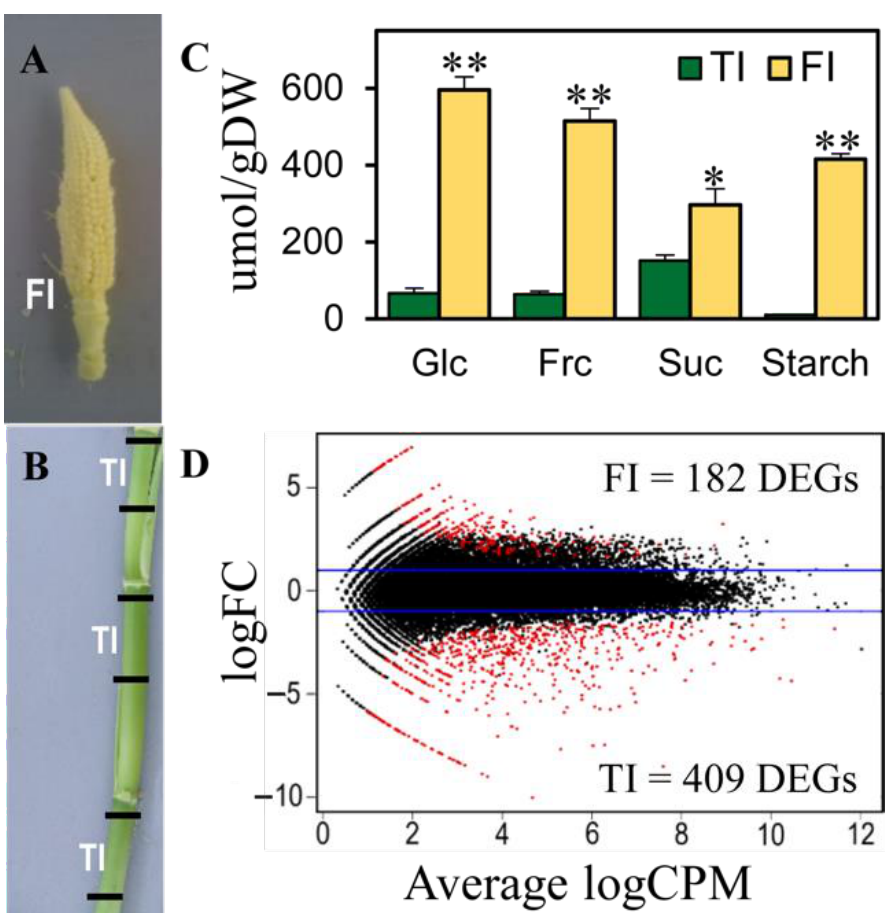
Figure 3. Transcriptomic comparison of the female inflorescence and top internode of the maize stem at 60 DAS. ( A , B ) Tissues used to build the libraries for transcriptomic analysis; ( A ) FI, female inflorescence and ( B ) TI, top internode. ( C ) Carbohydrate level differences between FI and TI; mean ± SE, n = 10, unpaired t -test, df = 10, * p < 0.05, ** p < 0.01. ( D ) Differentially expressed genes (DEGs) between FI and TI; DEGs visualized as a MA plot (log ratio vs. abundance) where each dot represents a gene, and a red dot represents a significantly DEG where FDR < 0.05 and log 2 FC (log of fold change) > |2|; log 2 CPM, log of count per